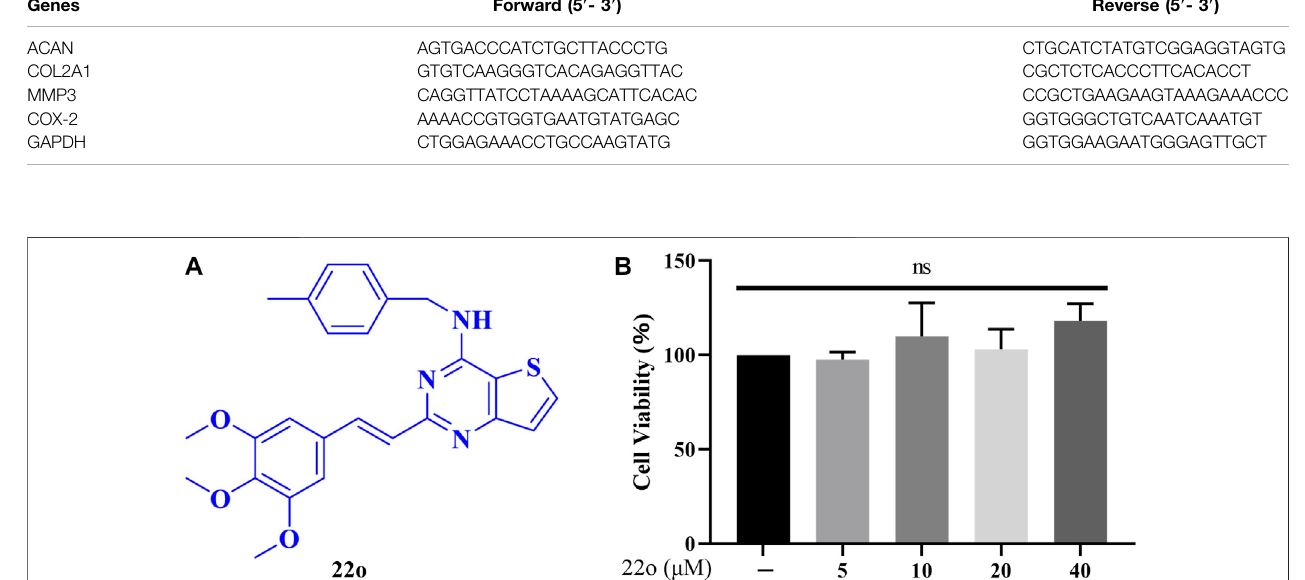
FIGURE1| Effectsofcompound22ooncellviability. (A) Chemicalstructure ofcompound22o. (B) Rat chondrocytes weretreatedwithcompound22o(5,10,20, and 40 μ M) for 24 h and cell viability was assessed by MTT assay ( n = 3). NS indicated no signi fi cance.